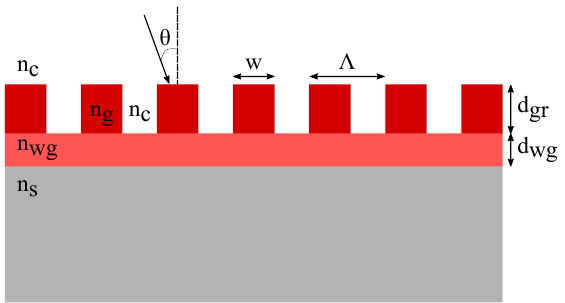
Figure 1. A schematic representation of a guided mode resonance (GMR) grating structure: A grating on top of a slab